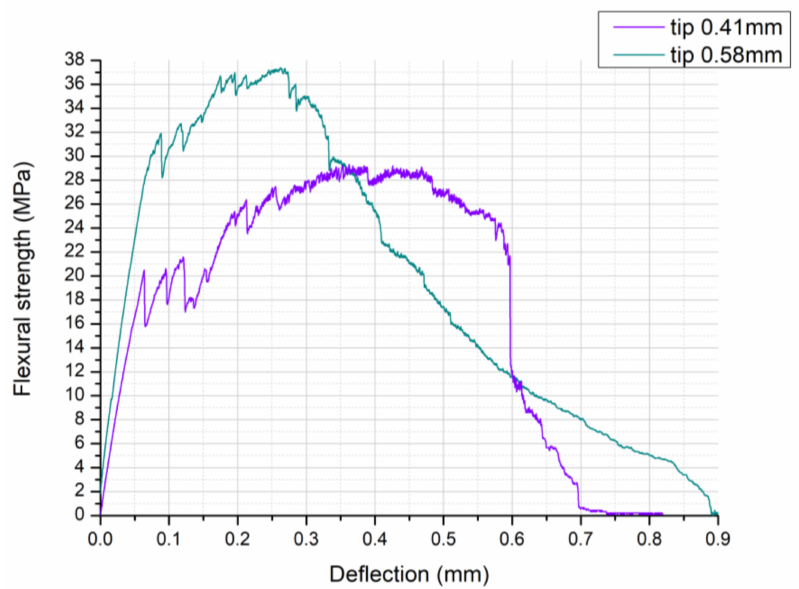
Figure 7. Flexural strength σ f (MPa) against deflection (mm) for pyrolyzed filaments printed by extruding Ink B through a 410- µ m and a 580- µ m